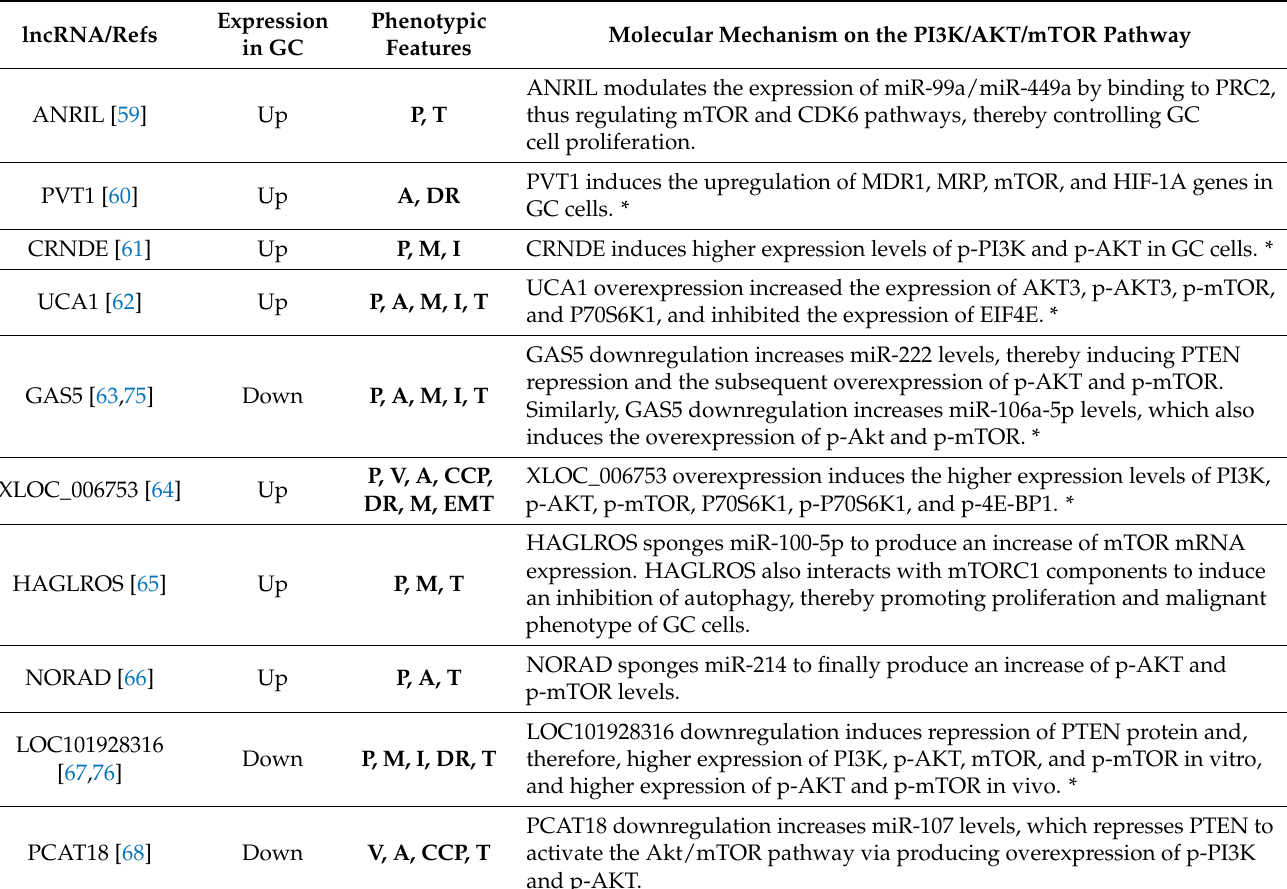
Table 2. Summary of the PI3K/AKT/mTOR pathway-related lncRNAs (ordered by year of study) according to phenotypic features in cancer and the mechanism by which they induce pathway activation in